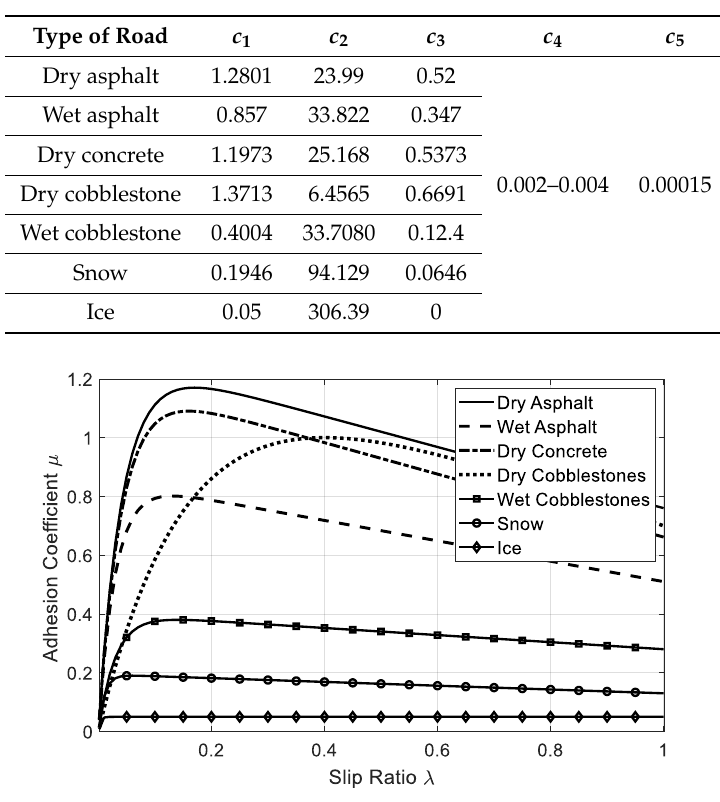
Table 1. Burckhard tire-road contact friction model parameter sets for typical road conditions.